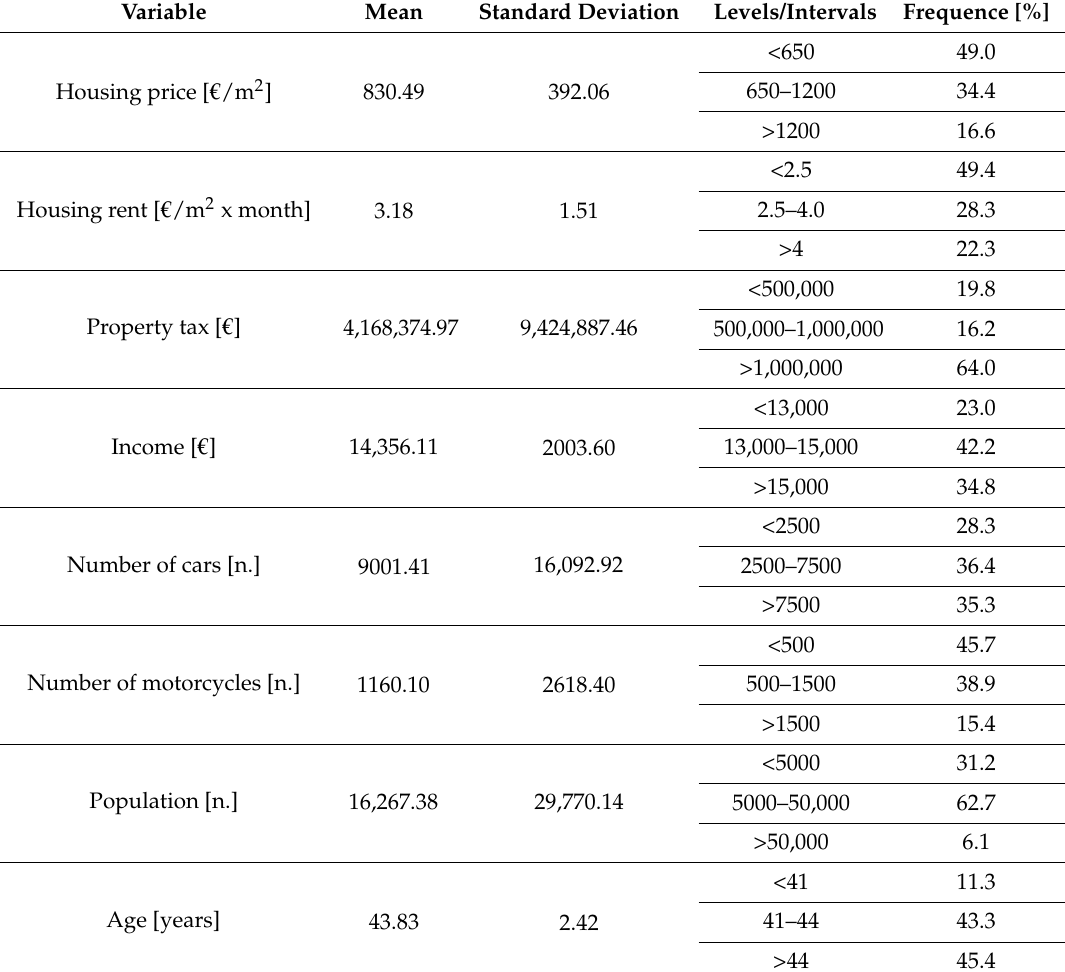
Table 2. Descriptive statistics of the variables of the sample in the year